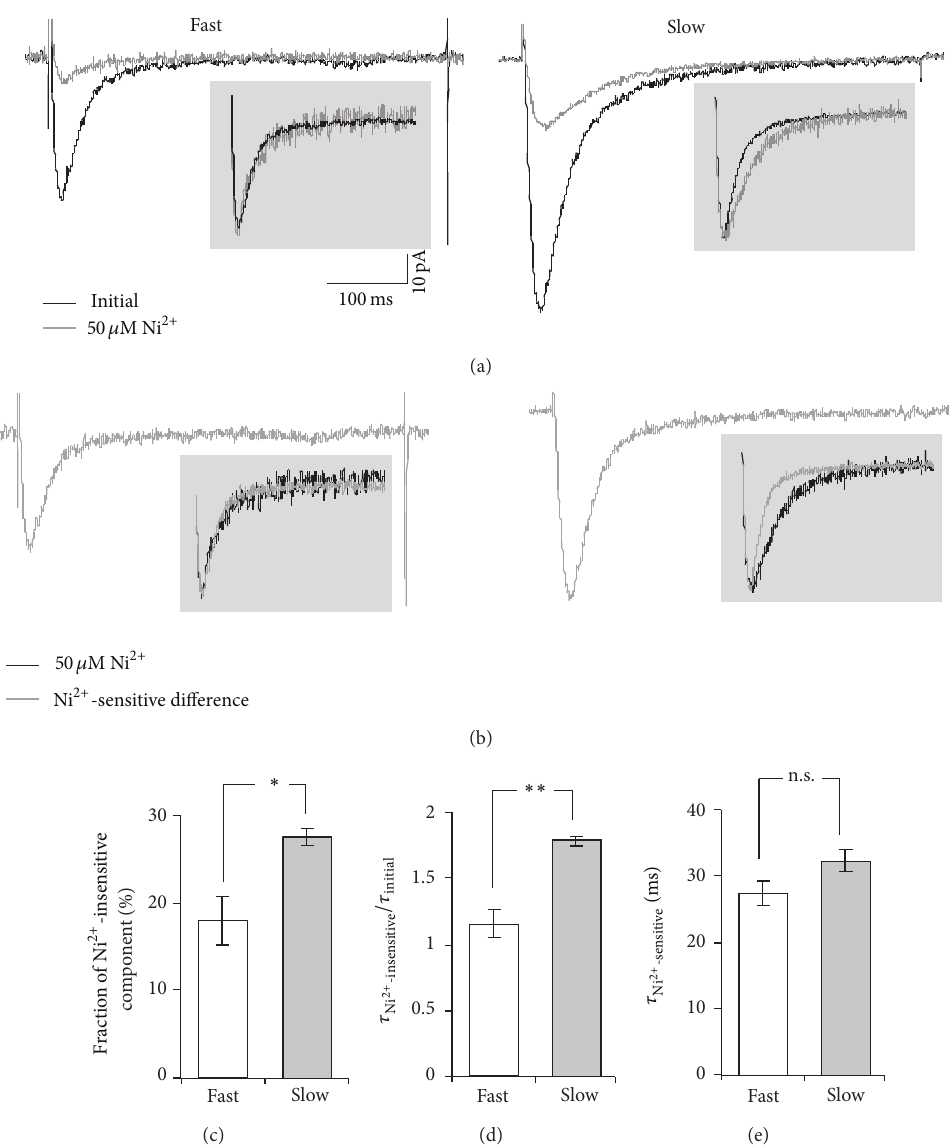
Figure 2: Fast and slow T-currents expressed by NTCN neurons reveal different sensitivity to low Ni 2+ concentration. (a) Representative current traces illustrate effect of Ni 2+ application to NTCN neurons of naive rats expressing fast (left) and slow (right) T-currents. Initial (total) T-current traces are shown in black while grey traces represent a residual Ni 2+ -insensitive component of T-current persisted during Ni 2+ application. Note the considerably larger blocking effect of Ni 2+ application on the fast compared to slow T-currents. Insets show the total and Ni 2+ -insensitive currents normalized by their amplitudes in order to directly compare their inactivation kinetics further shown in (c). Note the slower inactivation of Ni 2+ -insensitive component compared to the total current for the case of slow T-current. Scale bars shown in (a) are applicable to all current traces in (a) and (b). (b) Representative traces for a Ni 2+ -sensitive component of fast (left) and slow (right) T-currents were obtained by digital subtraction of the Ni 2+ -insensitive component from the total T-current for traces shown in (a). Insets demonstrate normalized Ni 2+ -sensitive (gray) and Ni 2+ -insensitive (black) components. Note the absence of visible difference in kinetics of inactivation between these components of the fast T-current and a substantially slower Ni 2+ -insensitive component as compared to the Ni 2+ - sensitive one for the case of slow T-current. (c) Fractions of Ni 2+ -insensitive component in the fast and slow T-currents were significantly different. ∗ - 𝑃 < 0.05 . (d) A ratio of inactivation kinetics of Ni 2+ -insensitive component and the total T-current for NTCN neurons expressing the fast and slow T-currents. There were no significant changes observed in the case of fast T-current ( 𝑃 > 0.4 ), while the inactivation kinetics of Ni 2+ -insensitive component of slow T-current was significantly slower compared to the inactivation kinetics of the total current. ∗∗ - 𝑃 < 0.01 . (e) Inactivation kinetics of Ni 2+ -sensitive components of fast and slow T-currents. n.s.: no significant difference was revealed between the inactivation kinetics of Ni 2+ -sensitive components of the fast and slow T-currents ( 𝑃 > 0.3 ). Each column in (c), (d), and (e) is the mean and SEM from 6 fast and 3 slow